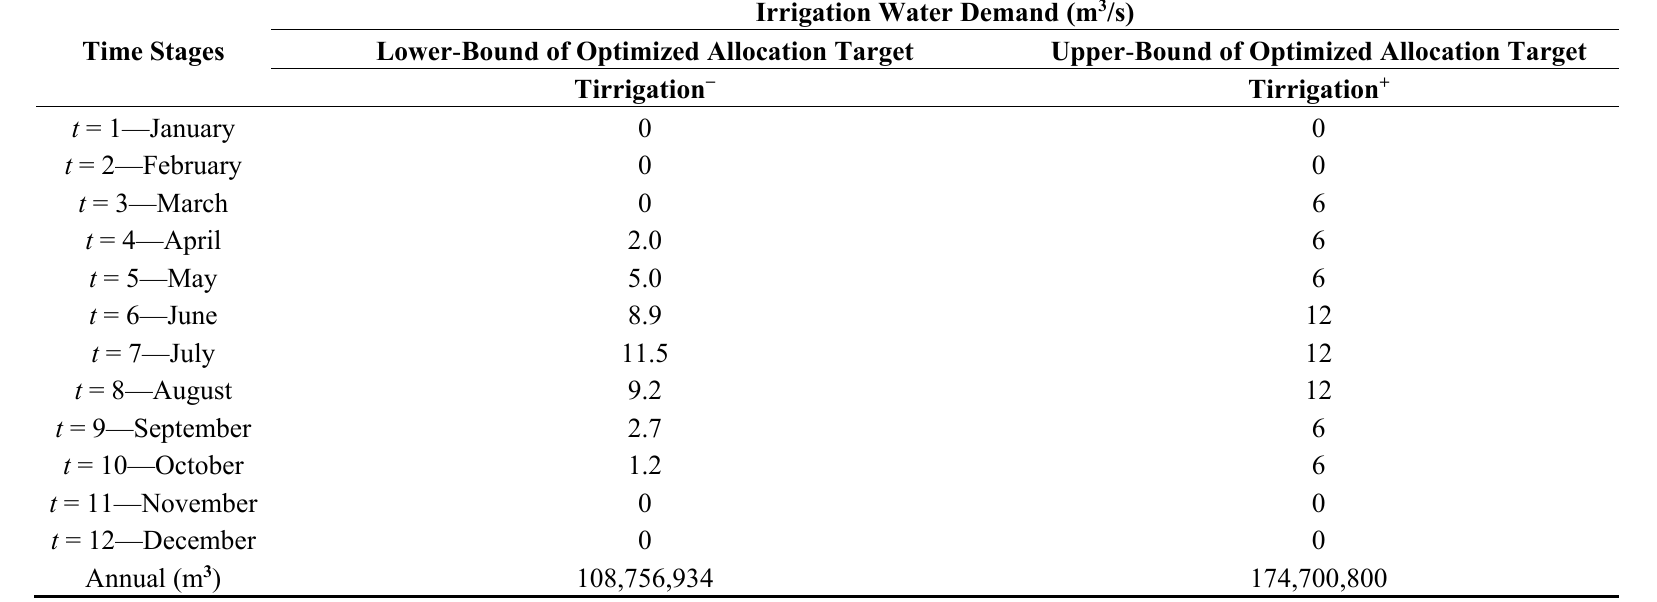
Table 2. Upper- and lower-water allocation targets for irrigation in EUR/m 3 .